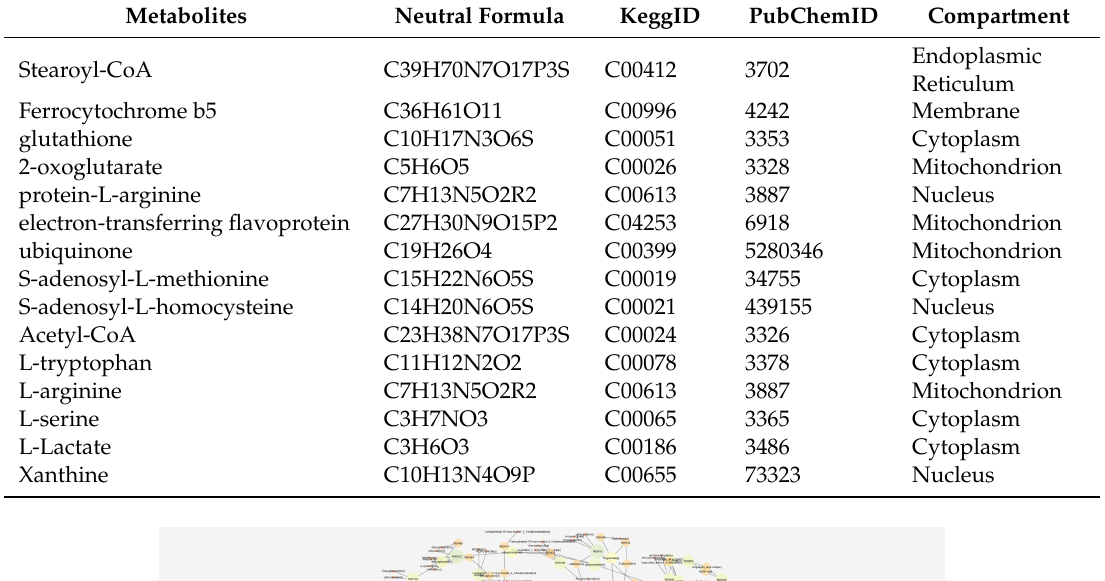
Table 7. First 15 hub metabolites of the acidosis metabolic network.